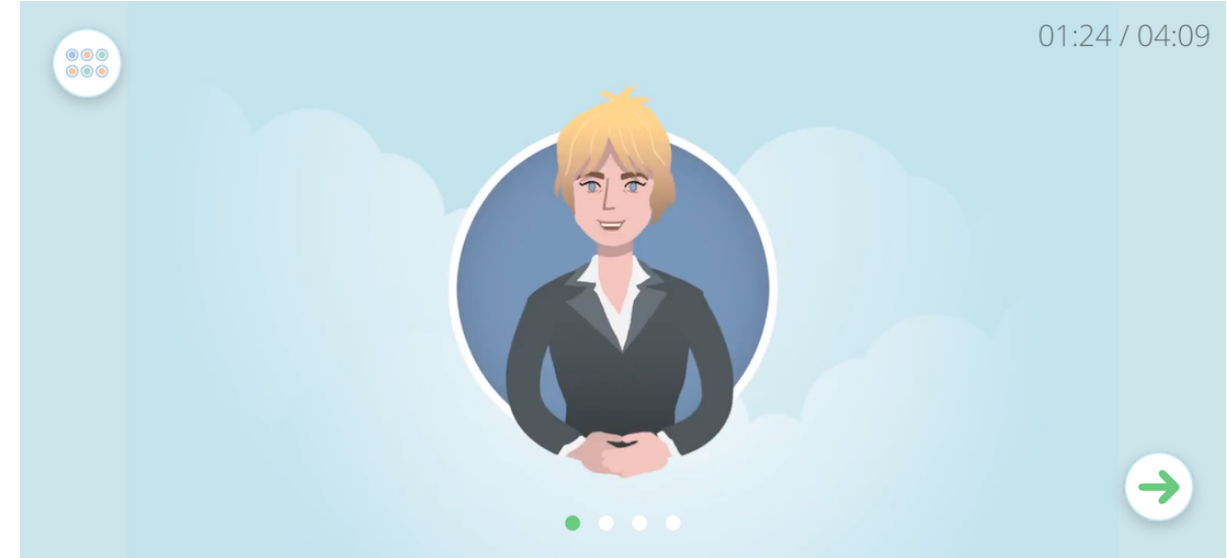
Figure 2. The virtual therapist and guide of ZeroPhobia.